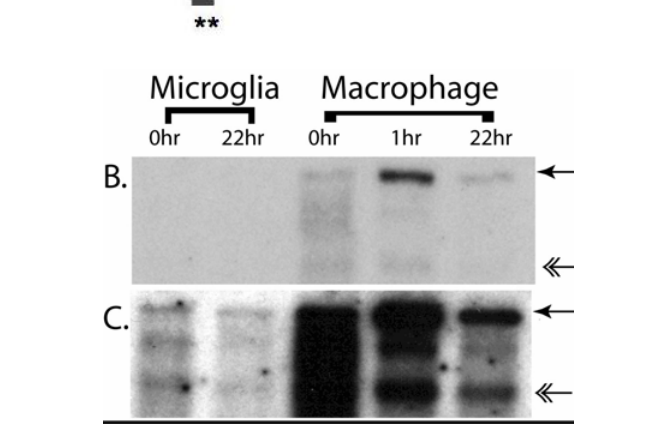
FIGURE 1 . Golli-MBP expression is enriched in culture macrophages as compared to cultured microglia. (A) The exon structures of two Golli-MBP transcripts are schematically represented. Exons encoding Golli-specific amino acids are depicted in white, exons encoding “classic” MBP amino acids are depicted in grey. The single asterisk/grey line identifies the sequence from exon 5c used for in situ hybridization probes (Figs. 2 and 3). The double asterisk/grey line identifies the sequence from exon 5a used for northern blot probes (Fig. 1B, C). (B and C) Northern blot analysis of mRNA isolated from microglia, purified by flow cytometry from mixed glial cultures and thioglycolate-elicited peritoneal macrophages. Cells were either untreated or treated for 22 h with LPS/IFNg. The dark single arrow indicates the 5.1-Kb BG21 transcript, the double arrow indicates the 2.6-Kb J37 transcript. “B” represents a 16-h exposure and “C” represents a 2-week exposure of the same northern